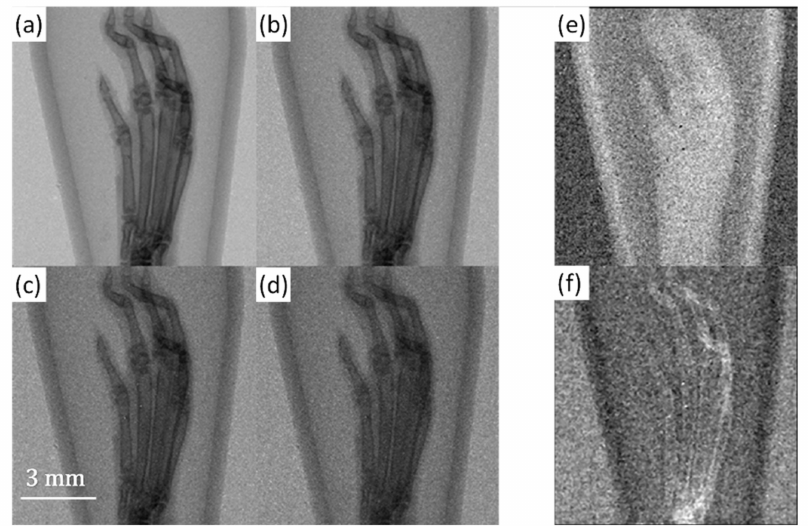
Figure 8. Results for a single projection of the mouse hand sample at energy thresholds ( a ) E 1 = 16 keV, ( b ) E 2 = 21.1 keV, ( c ) E 3 = 23.9 keV and ( d ) E 4 = 29.7 keV. The corresponding result for the retrieved thickness after applying the matrix method is shown for ( e ) soft tissue and ( f )